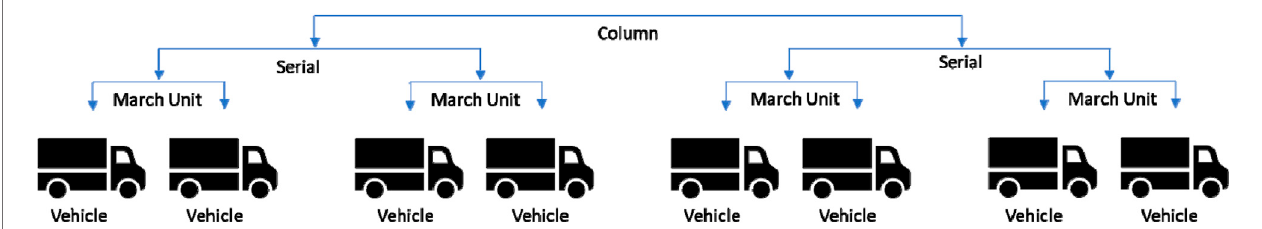
FIGURE 2 | Convoy